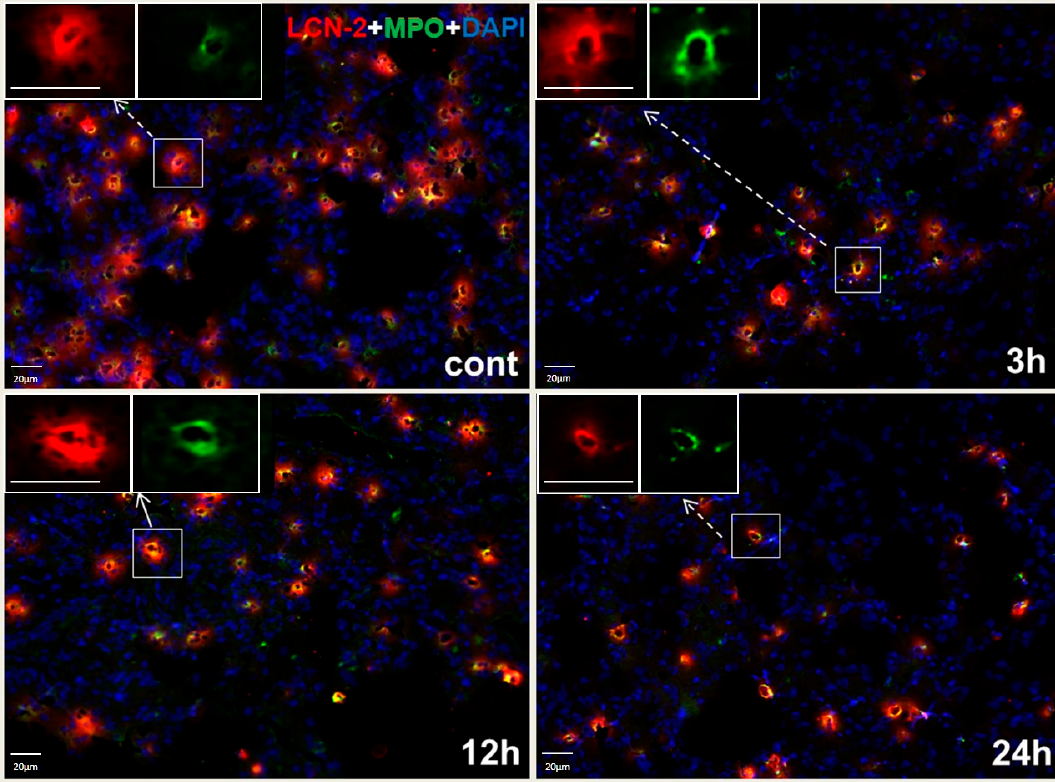
Figure 4. Double immunofluorescence staining of LCN2 and myeloperoxidase (MPO)-positive cells in representative sections of lung tissue for control rats (cont) and 3, 12 and 24 h after irradiation. Cryosections were stained with anti-LCN2 (red) and anti-MPO (green), followed by fluorescence immunodetection. Counterstaining of the nuclei was done with DAPI (blue) (original magnification 200×, scale bar = 20 μ m).